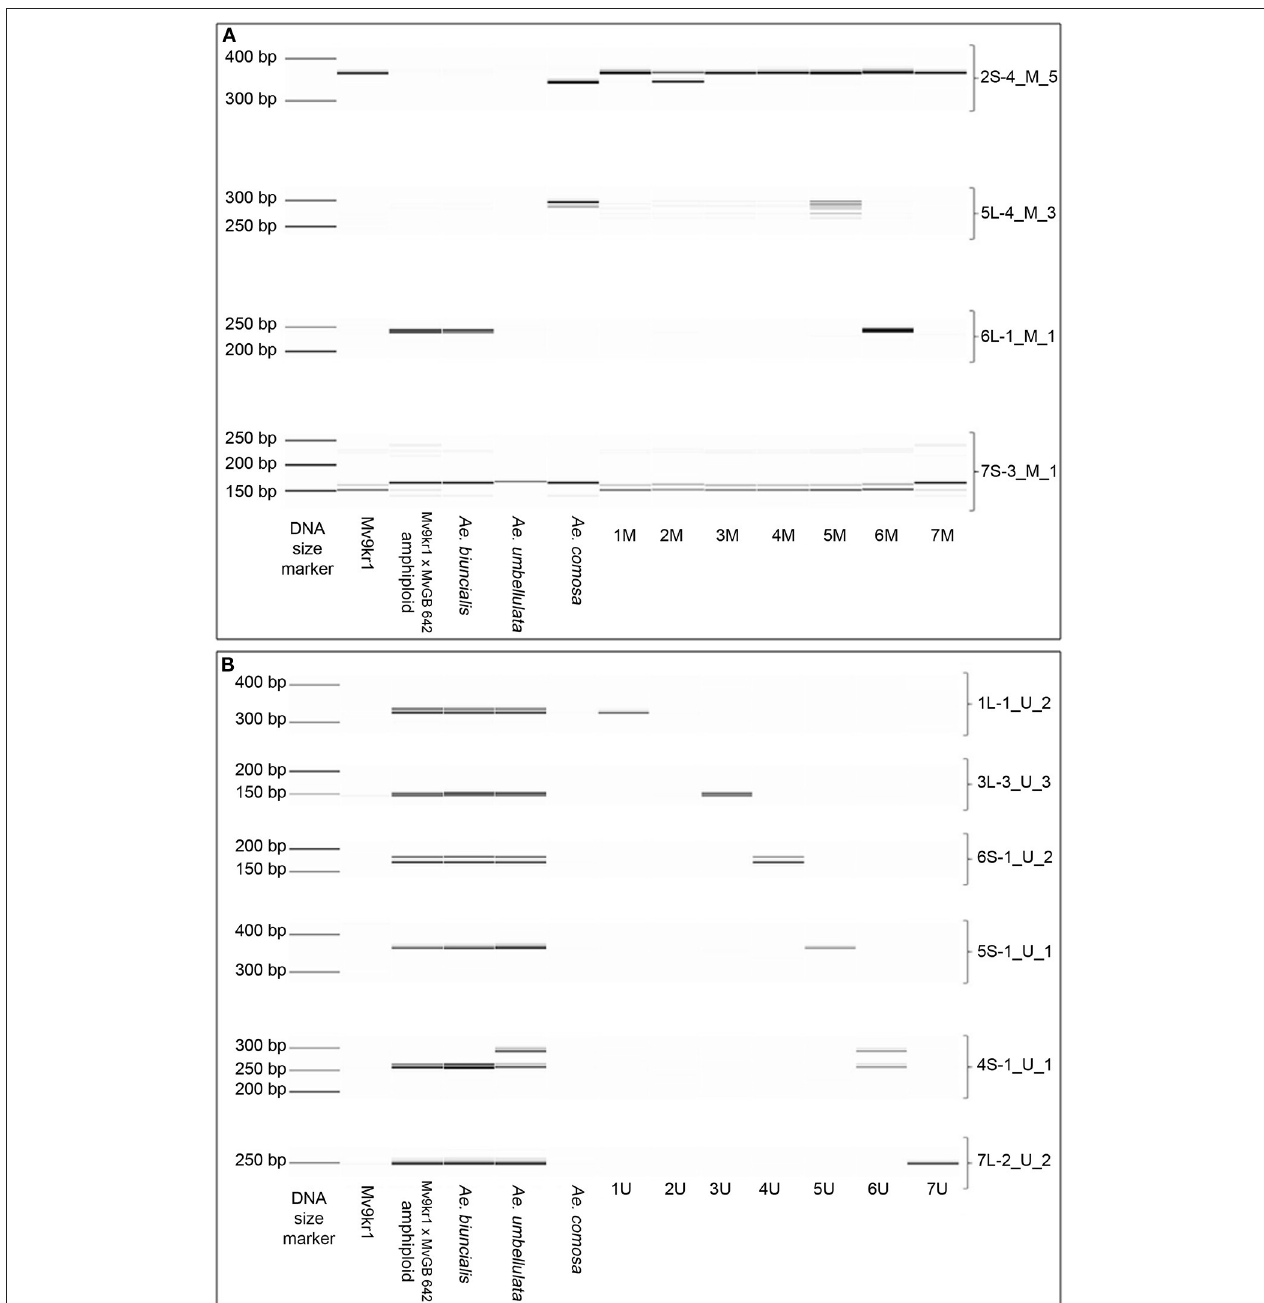
FIGURE 7 | Digital capillary electrophoretic pattern of the cDNA-derived markers designed by the use of corresponding (A) M or (B) U chromosomal sequences determined by the BLASTn search. The markers were tested on hexaploid wheat line Mv9kr1, on Ae. biuncialis MvGB642 accession, wheat- Ae. biuncialis MvGB 642 amphiploid, and Ae. comosa MvGB1039 and Ae. umbellulata AE740/03. The markers were also tested on wheat- Ae. comosa (2M − 7M), wheat- Ae. umbellulata (1U, 2U, 6U, 7U), and wheat- Ae. geniculata (1M, 3U, 4U, 5U) disomic chromosome addition lines representing the whole set of M- or U-genome chromosomes. A 35–500 bp DNA ladder was used as a molecular-weight size marker to estimate the fragment size.